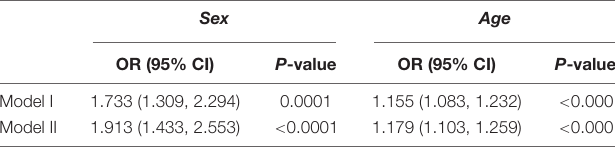
Data in the table: OR (95% CI), P-value. Result variable: HUTT results. Exposure variable: Sex/Age. Model I in sex adjusted for: None. Model II in sex adjusted for: Age. Model I in age adjusted for: None. Model II in age adjusted for: Sex.